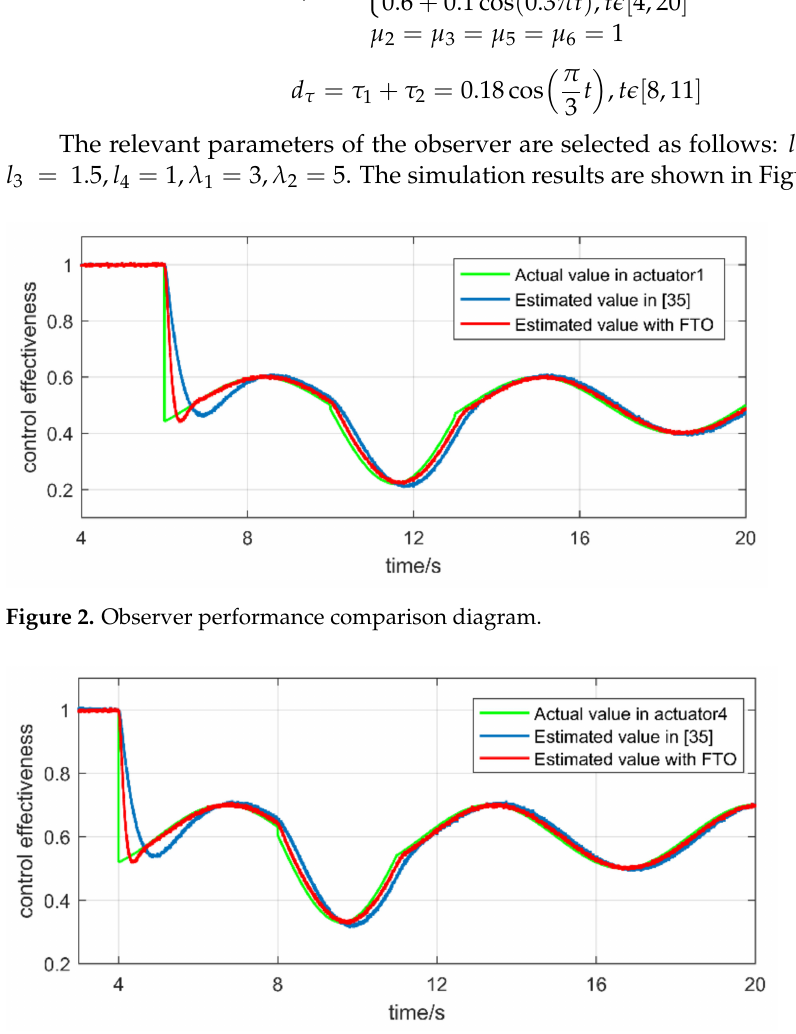
Figure 3. Observer performance comparison